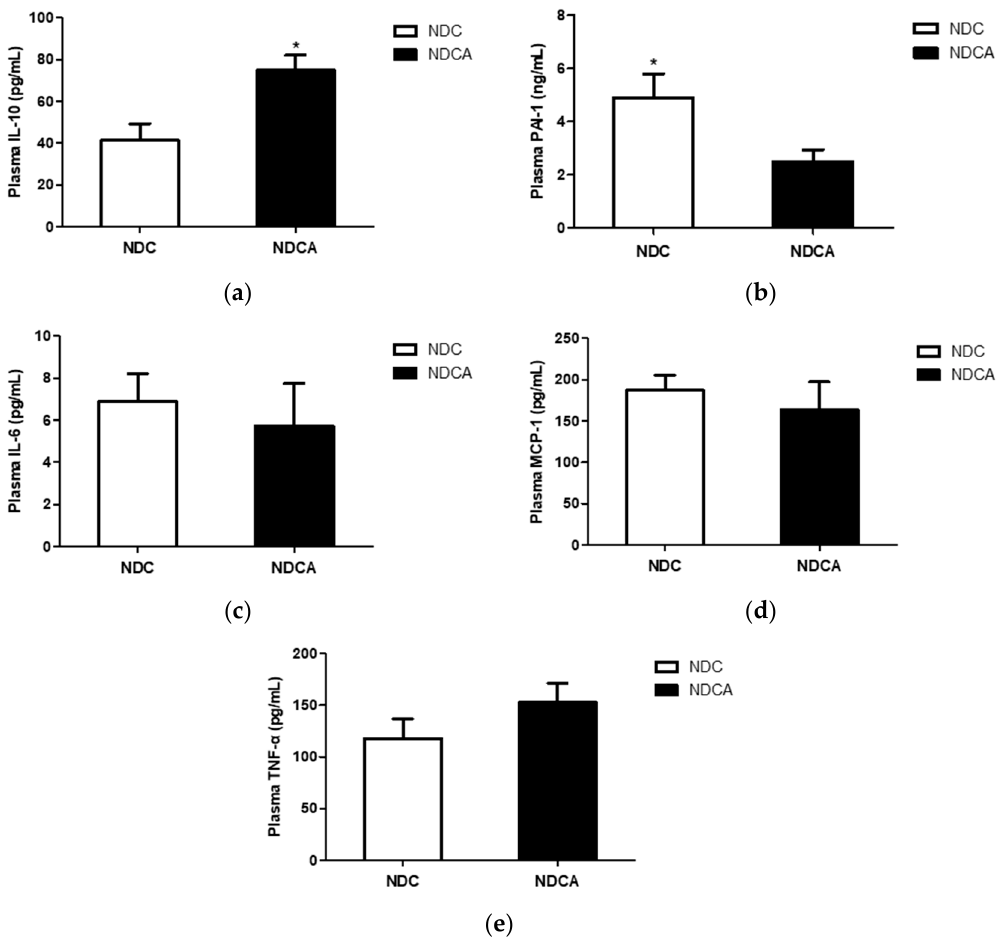
Figure 9. Effect of supplementation of a non-dairy creamer-enriched high-fat diet with D-allulose on plasma cytokines in C57BL/6J mice fed the diet for 8 weeks: ( a ) plasma interleukin-10 (IL-10); ( b ) plasma plasminogen activator inhibitor-1 (PAI-1); ( c ) plasma IL-6; ( d ) plasma monocyte chemoattractant protein-1 (MCP-1); ( e ) plasma tumor necrosis factor- α (TNF- α ). Data are mean ± SE. Significant differences between the 5% D-allulose group and without D-allulose group are indicated; * p < 0.05. NDCA, high-fat diet with non-dairy creamer + 5% D-allulose; NDC, high-fat diet with non-dairy creamer.